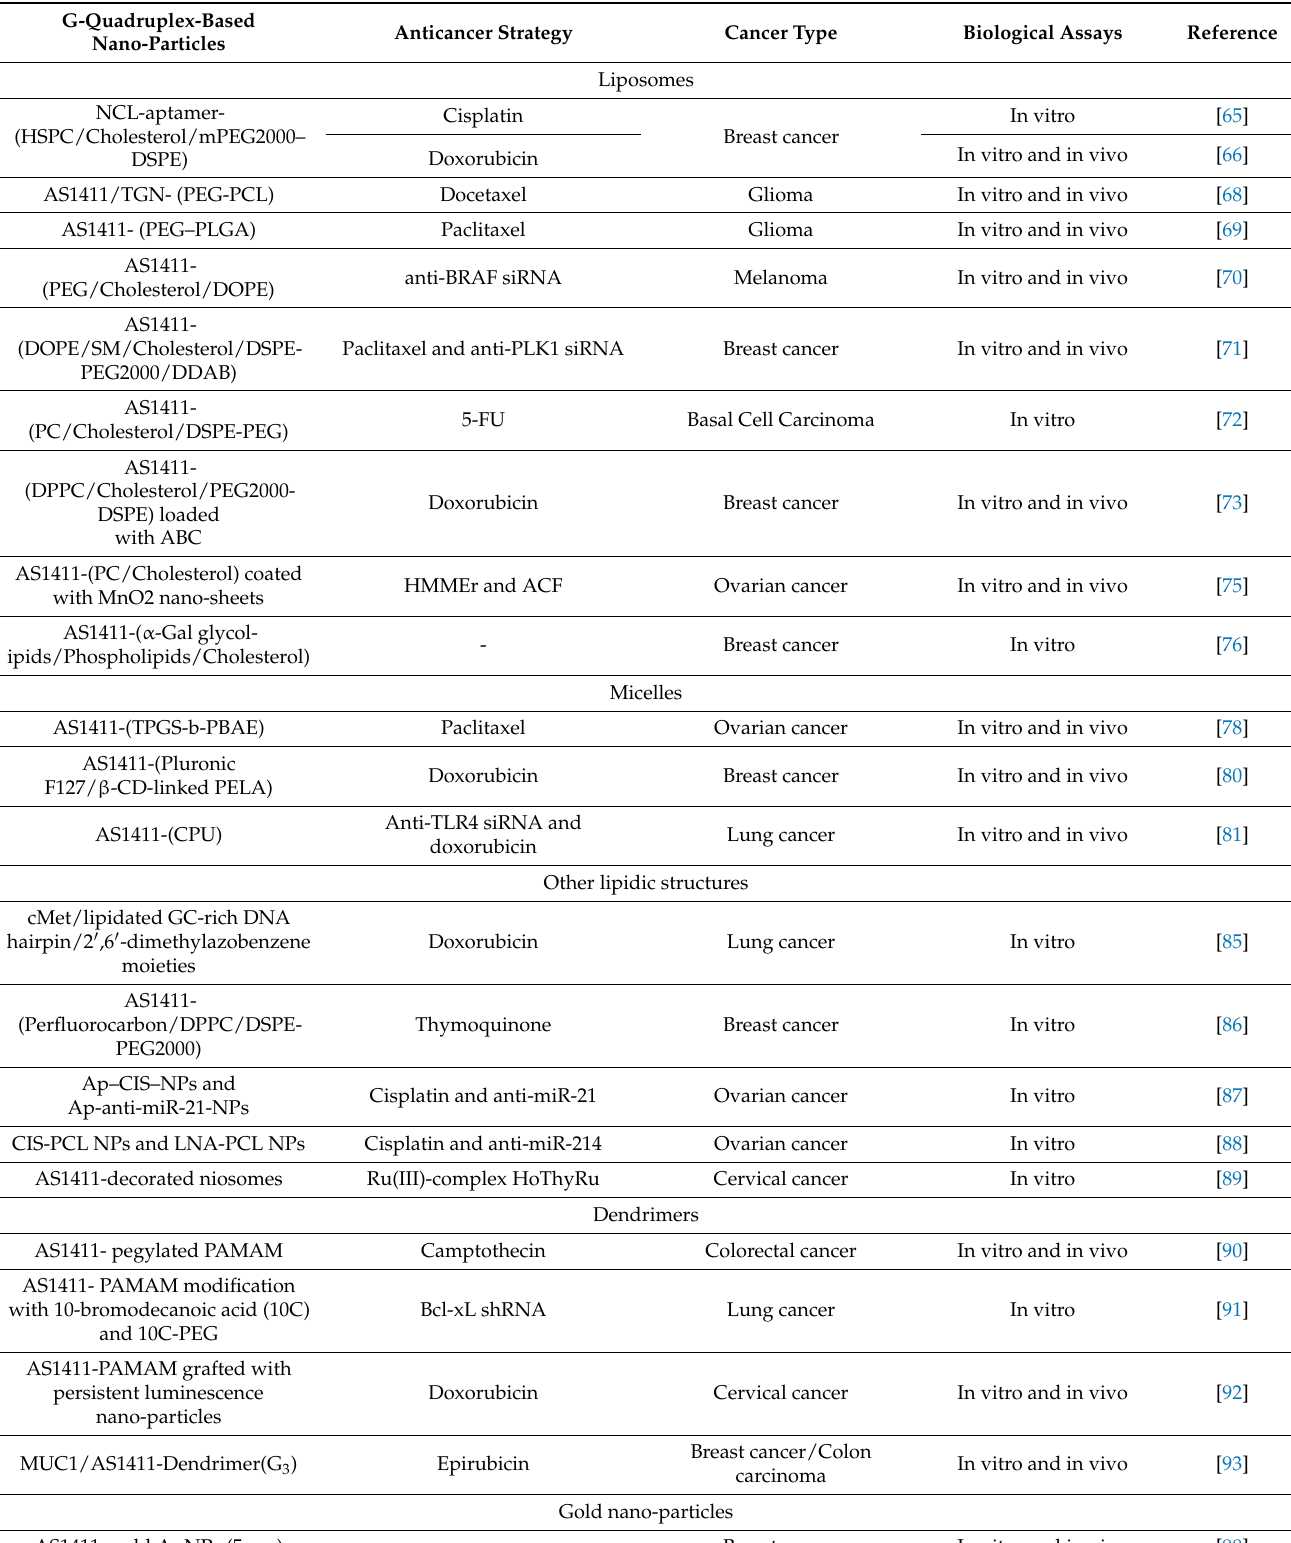
Table 2. G4-based nano-particles and biological assays used to analyze the anticancer